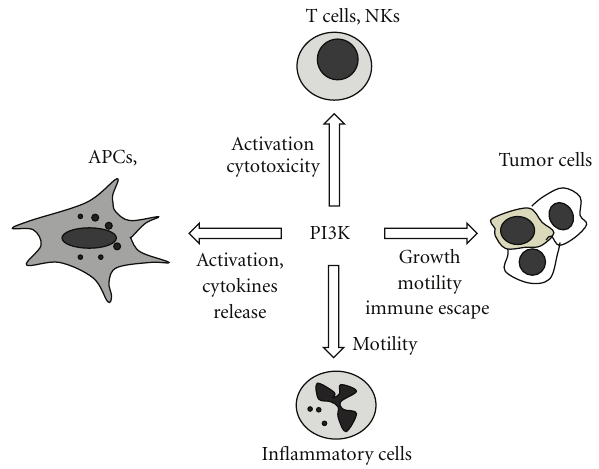
Figure 1: Schematic model of the PI3K signaling pathway involved in the regulation of a broad range of cellular activities in both immune system and